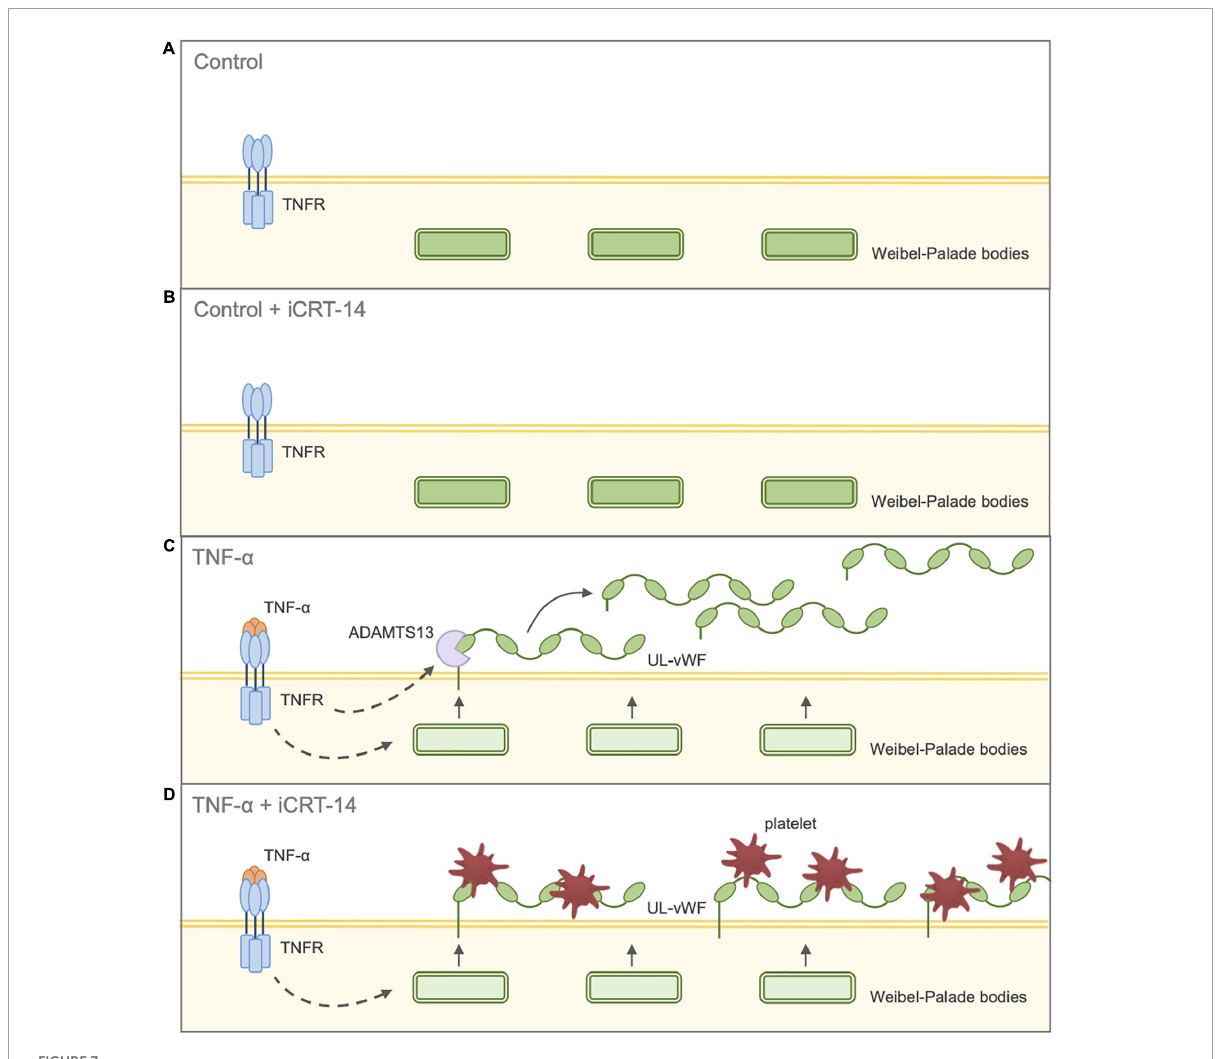
FIGURE7 Schematic diagram illustrating effect of inhibition of Wnt/ β -catenin signaling on endothelial-platelet interaction in unchallenged and TNF- α -challenged cultured endothelial cells. Endothelial cells were treated with either 0.05% DMSO vehicle control or 25 µ M iCRT in the presence or absence of 10 ng/mL recombinant human TNF- α stimulus for 18 h, then co-cultured with thrombin-activated platelets for 10 min. (A) Control: Unchallenged endothelial cells treated with 0.05% DMSO vehicle control. UL-vWF multimers remain stored in the Weibel-Palade bodies. (B) Control + iCRT-14: Unchallenged endothelial cells treated with 25 µ M iCRT-14. UL-vWF multimers remain stored in the Weibel-Palade bodies. (C) TNF- α : TNF- α -challenged endothelial cells treated with 0.05% DMSO vehicle control. TNF- α stimulates release of UL-vWF from Weibel–Palade bodies. TNF- α -driven up-regulation in ADAMTS13 results in proteolytic cleavage of membrane-tethered UL-vWF; hence, TNF- α -stimulation does not promote endothelial-platelet interaction. (D) TNF- α + iCRT-14: TNF- α -challenged endothelial cells